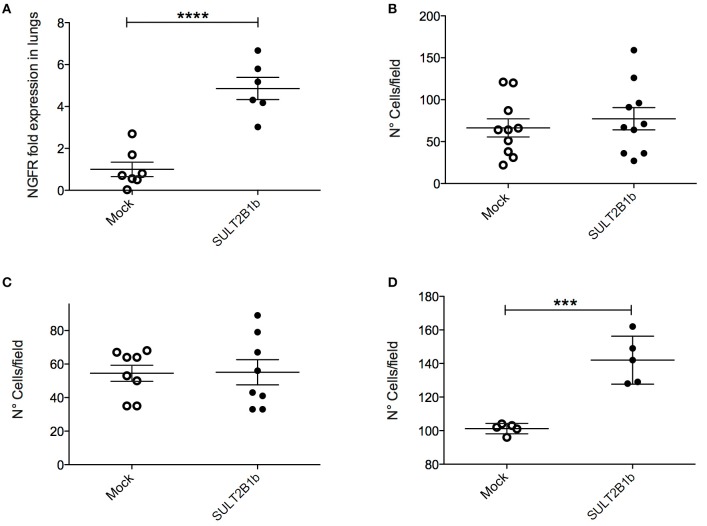
In vivo and in vitro analysis of SULT2B1b-4T1 cell metastatic capabilities. (A) qPCR analysis of lungs after the injection of SULT2B1b-4T1 cells in the tail vein of naive mice. (B–D)
in vitro migration assays using transwell chambers untreated (B), or coated with a matrigel layer (C), or filled up with a monolayer of HUVEC cells left growing on top of the filter (D). ***p < 0.001; ****p < 0.0001 (Student's t-test).